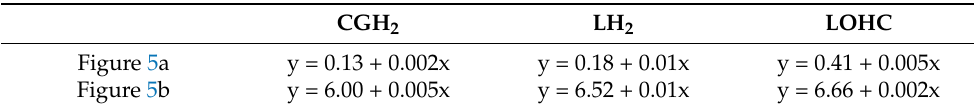
Table 6. Linear fit for hydrogen transportation cost (Figure 5a) and hydrogen supply chain cost (Figure